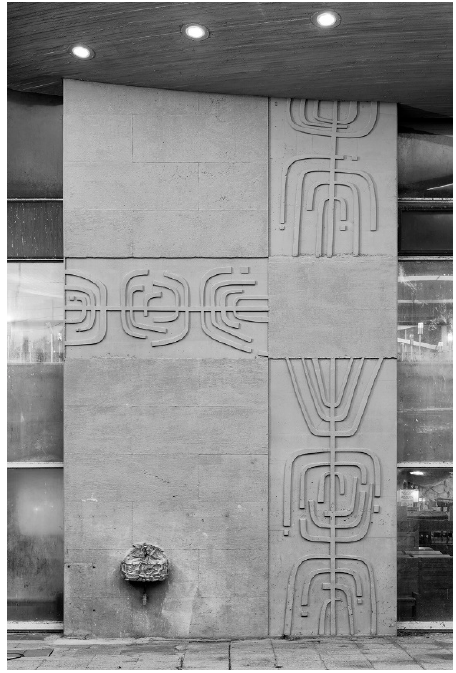
Figure 4. Artworks in the courtyard: Ruth Zarfati, relief, ca. 1968. Photo: Eli Singalovski, 2018. Used with permission.